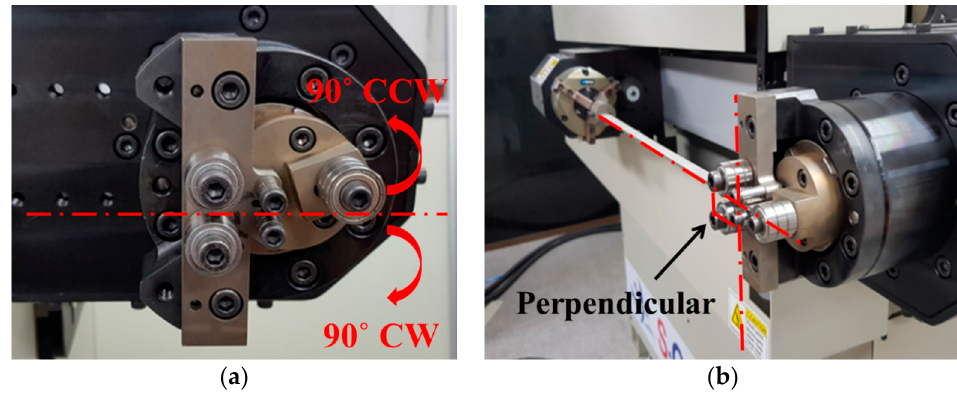
Figure 9. Bending unit for Nuss bar manufacturing by CNC bending machine. ( a ) This picture shows the maximum range of movement of the bending tool. ( b ) This picture shows the Nuss bar (straight) being inserted into the machine; the Nuss bar makes a 90-degree angle with the bending unit.